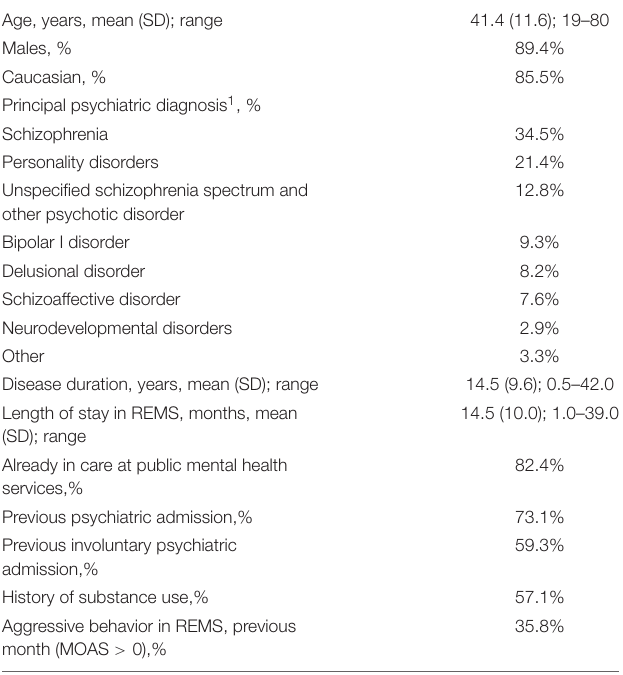
TABLE 1 | Sociodemographic and clinical characteristics of n = 681